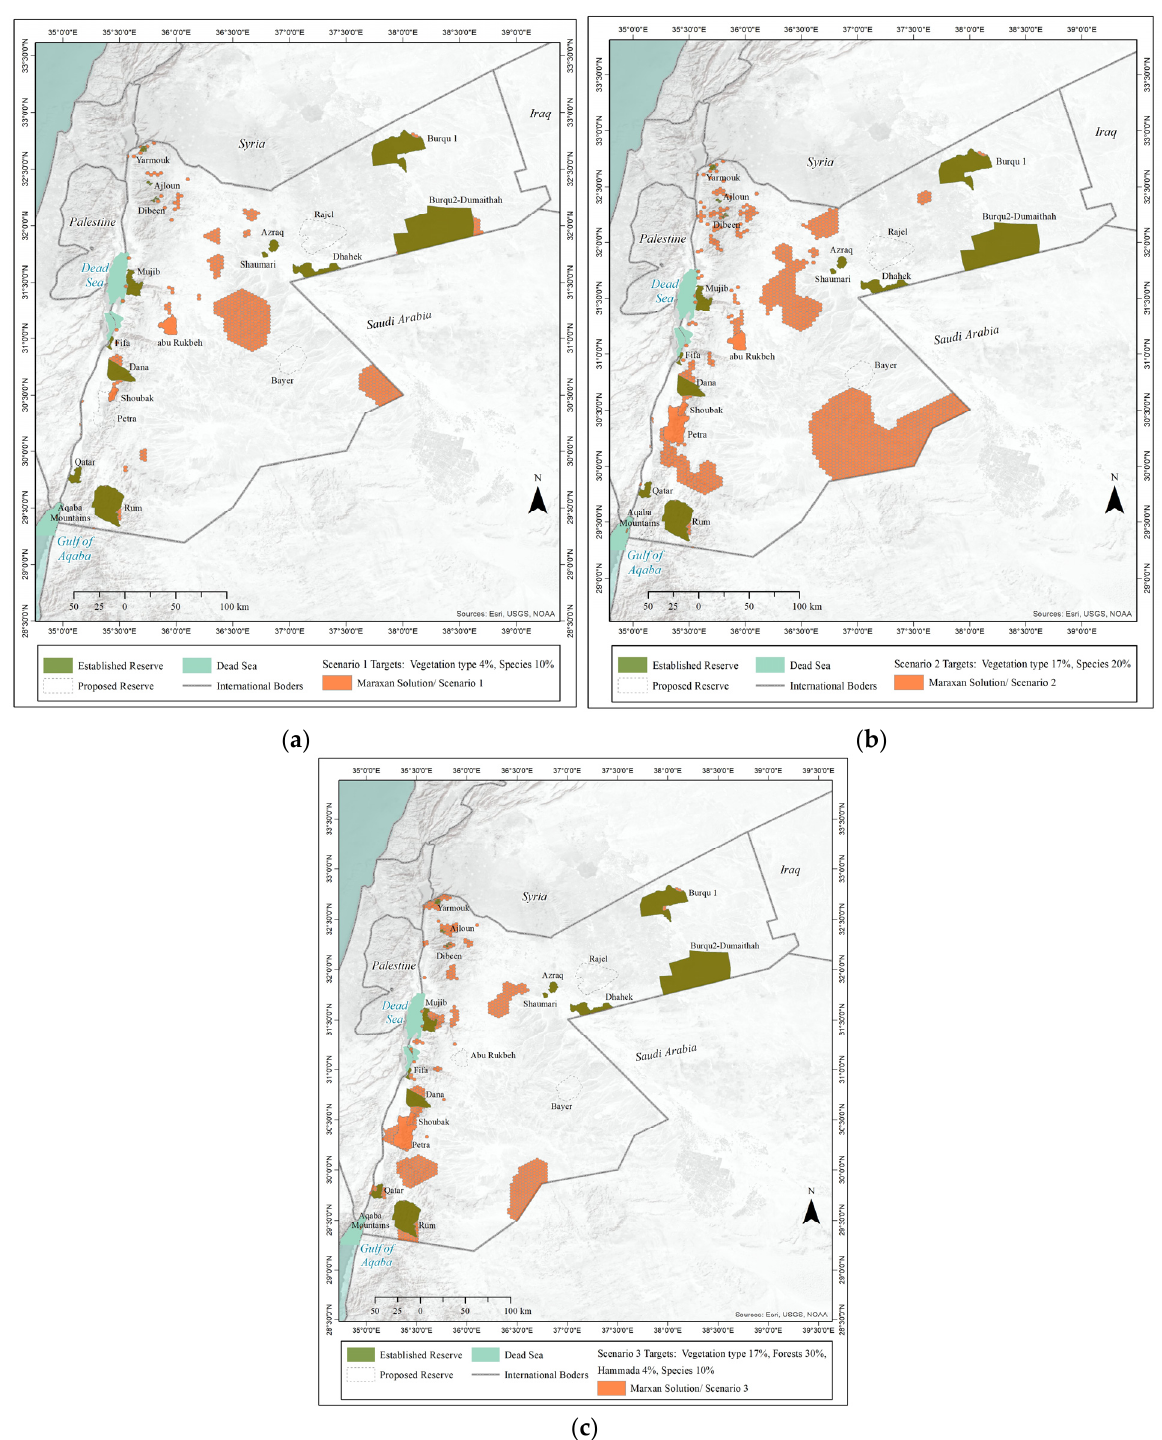
Figure 4. Marxan solution: ( a ) for scenario 1; ( b ) for scenario 2; and ( c ) for scenario 3.